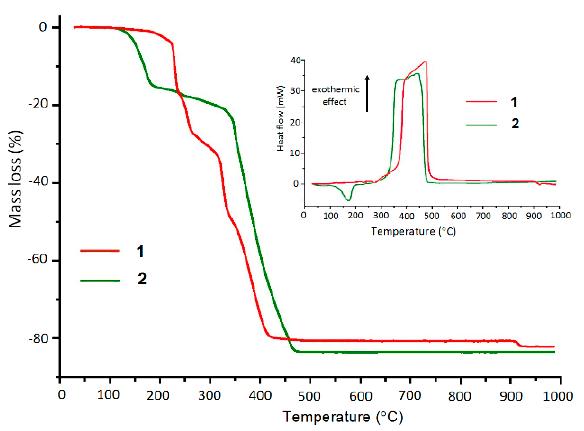
Figure 5. TG curves of 1 and 2 recorded in air atmosphere. The inset shows DSC curves. The 1D coordination polymer 2 showed lower thermal stability in comparison with 1 (Figure 5). The first mass loss (17.10%), observed on the TG curve at 150–200 °C, was ascribed to the release of four aqua ligands (calcd. 16.70%). The DSC profile indicated that the dehydration process took place in one step with an endothermic effect at 170 °C (peak top). A dehydrated sample was unstable on further heating, resulting in two-stage decomposition in the temperature ranges of 210–360 and 361–470 °C with mass losses of 5.37 and 59.70%, respectively. This significant mass loss corresponds to the burning of the organic ligand and the formation of NiO as a final solid residue [65]. 3.4. PXRD Analysis of Metal Oxides The PXRD patterns for the metal oxides (Figure 6), prepared on the basis of the compounds 1 and 2 , were compared with the reference data from the PDF ICDD data- base [66]. Heating of 1 at 1000 °C for 2 h gives a mixture of Co 3 O 4 (65(1)%) and CoO (35(1)%), according to the reference data 04-005-7243 and 01-076-3830, respectively. Co 3 O 4 is characterized by the following crystallographic data: cubic crystal system, space group F3d-3m, and unit cell parameters: a = b = c = 8.0920 Å, Z = 8, and V = 529.87 Å 3 . The crys- tallographic data of CoO are as follows: cubic crystal system, Fm-3m space group, and unit cell parameters: a = b = c = 4.7230 Å, Z = 4, and V = 78.02 Å 3 . Figure 6. PXRD patterns of cobalt oxides ( a ) and ( b ) nickel oxide.